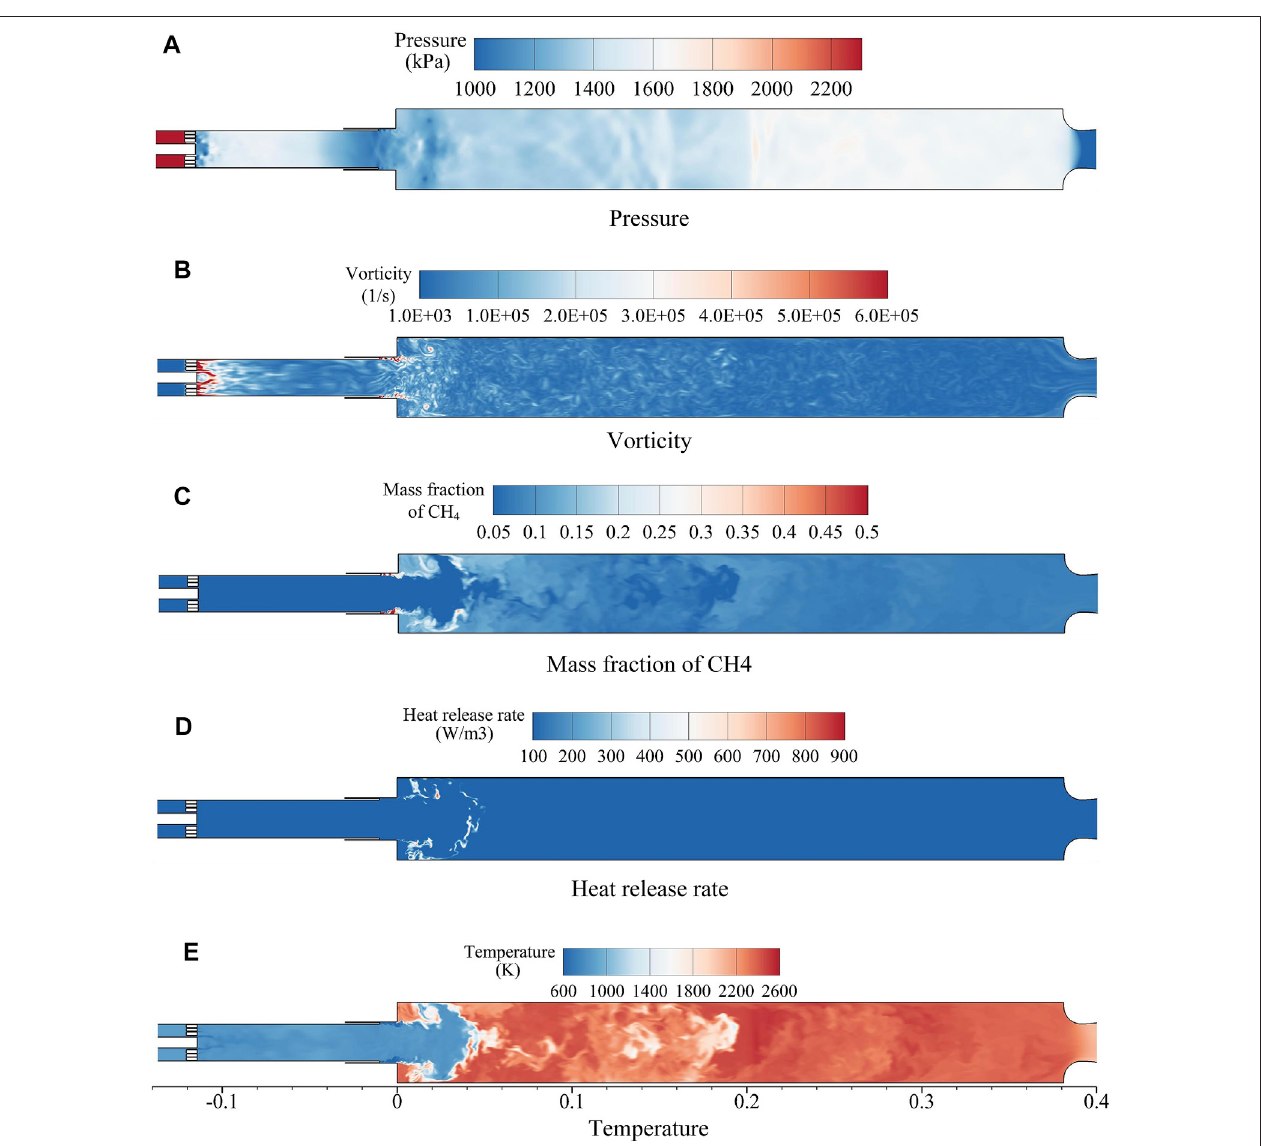
FIGURE 9 | Instantaneous snapshots of (A) pressure, (B) vorticity, (C) mass fraction of CH 4 , (D) heat release rate, and (E) temperature at t = 20.8237 ms